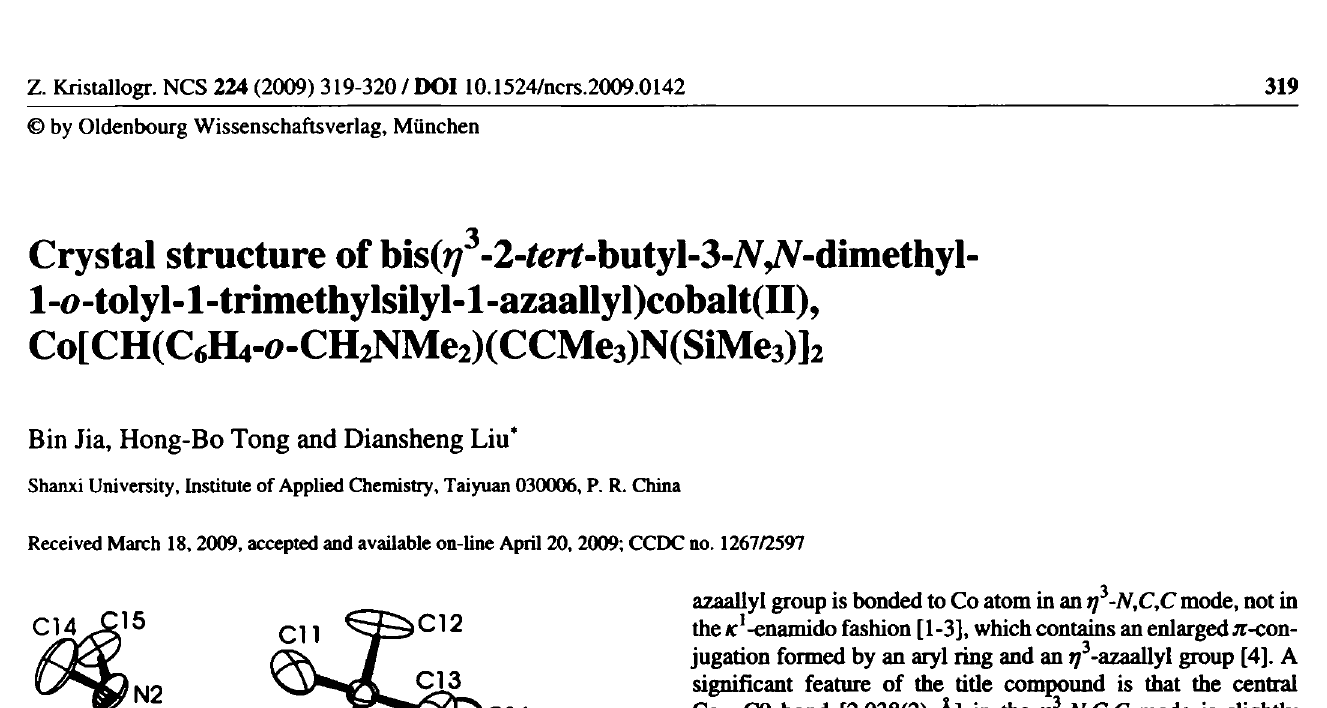
Table 1. Data collection and handling.